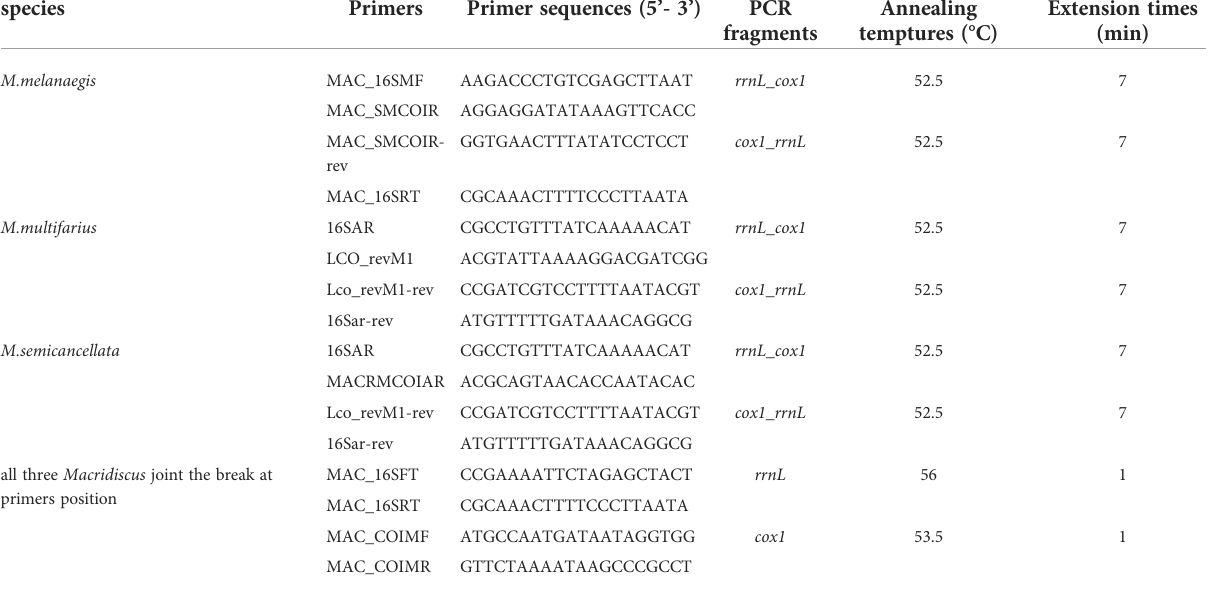
TABLE 1 LA-PCR Primers and conditions for amplifying the M-type mitogenomes of the three Macridiscus species.